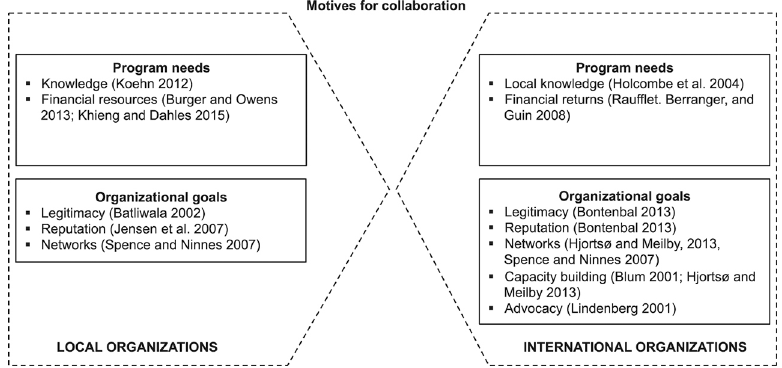
Figure 1: A framework for motives for collaboration within heterogeneous